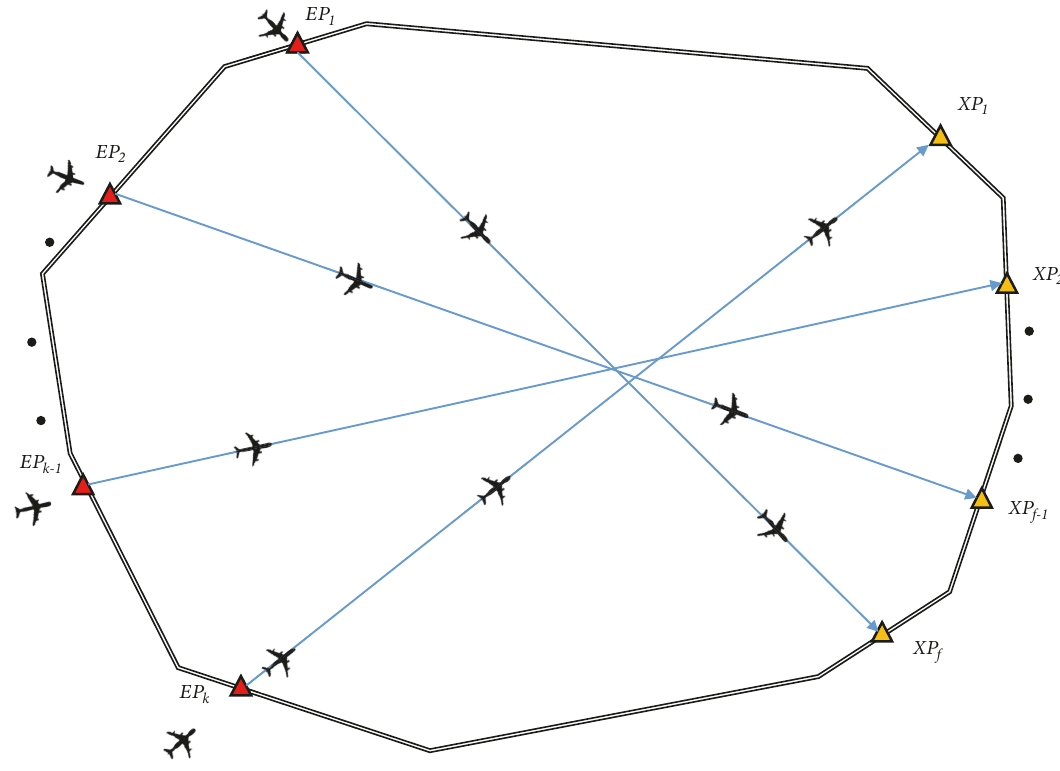
Figure 1: A generic free-route airspace (FRA)